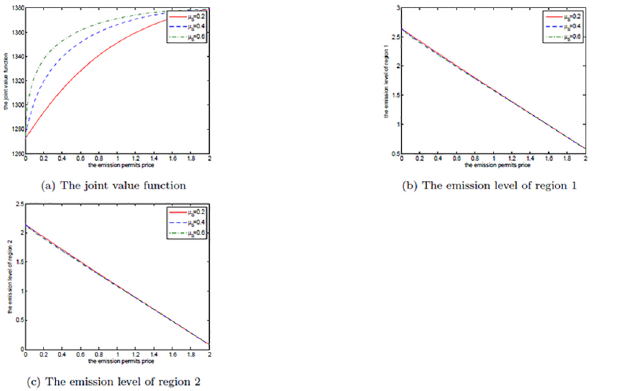
Fig 9. The effects of μ S on the cooperative game.